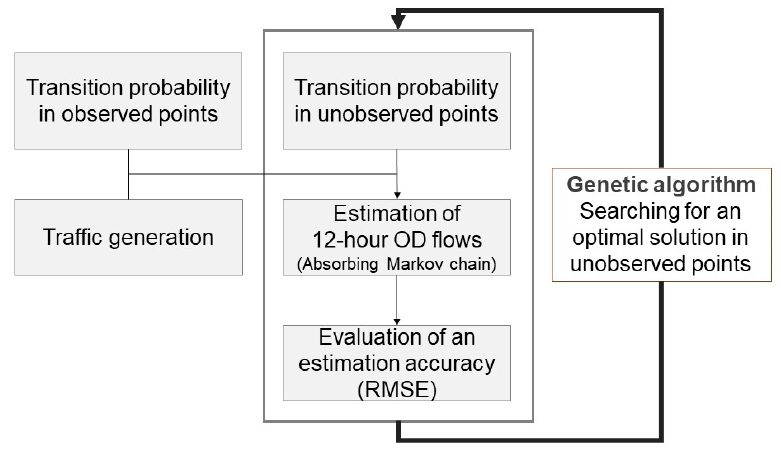
Figure 4. Flowchart for estimating OD flow.